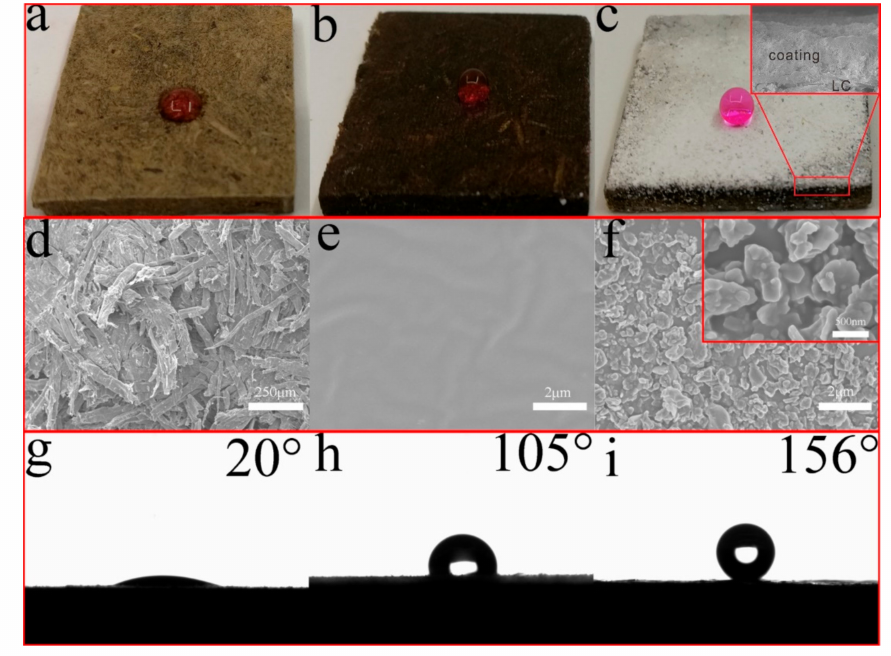
Figure 5. Digital photos, scanning electron microscopy (SEM) images and contact angles images of different surfaces: ( a , d , g ) LC; ( b , e , h ) LC coated with PDMS; ( c , f , i ) LC coated with PDMS@STA-KL.